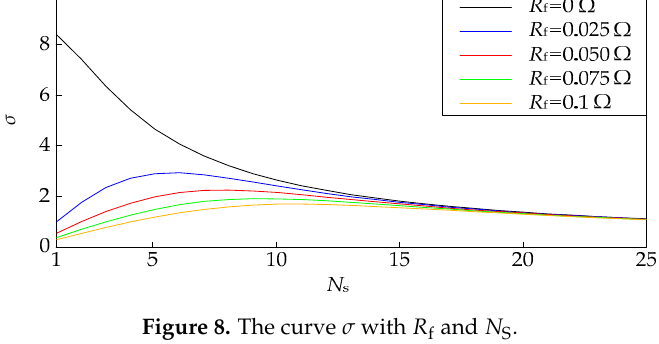
Figure 8. The curve σ with R f and N S .